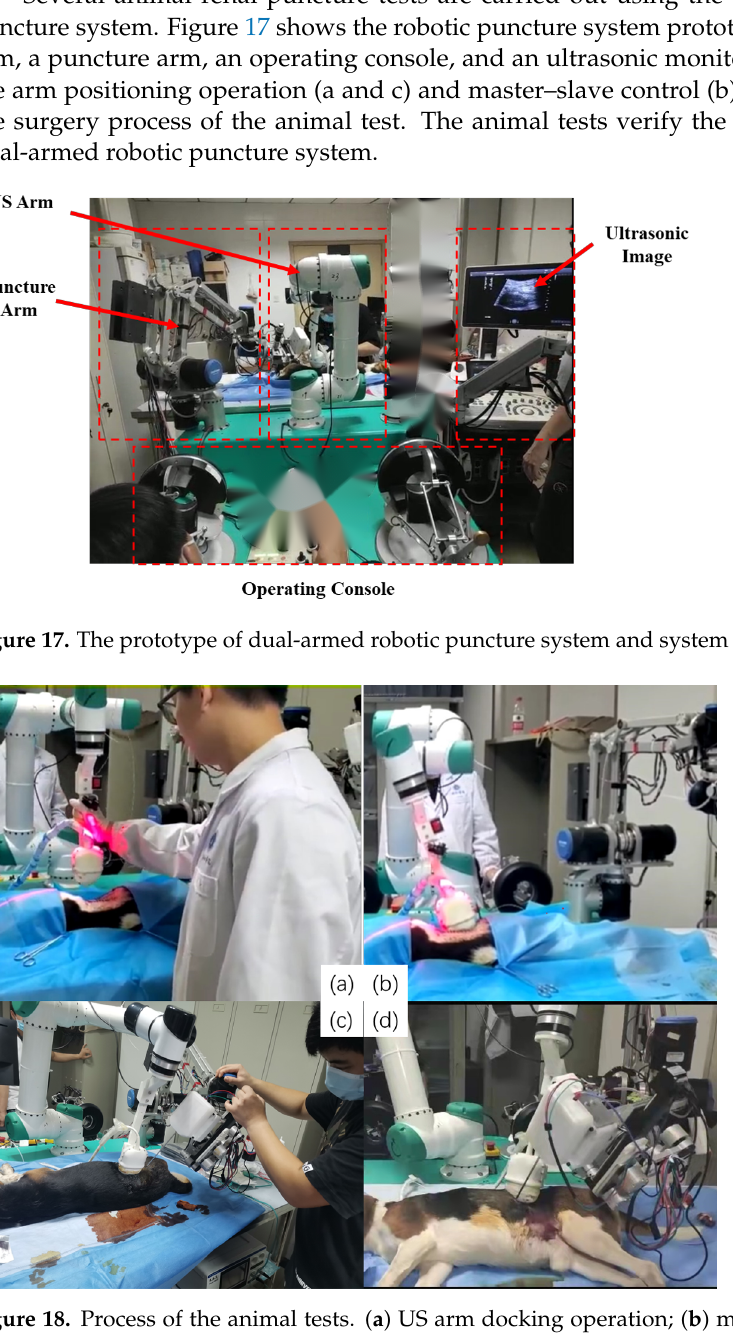
Figure 18. Process of the animal tests. ( a ) US arm docking operation; ( b ) master–slave control of US arm for image guidance; ( c ) puncture arm docking operation; ( d ) the surgery process of the animal